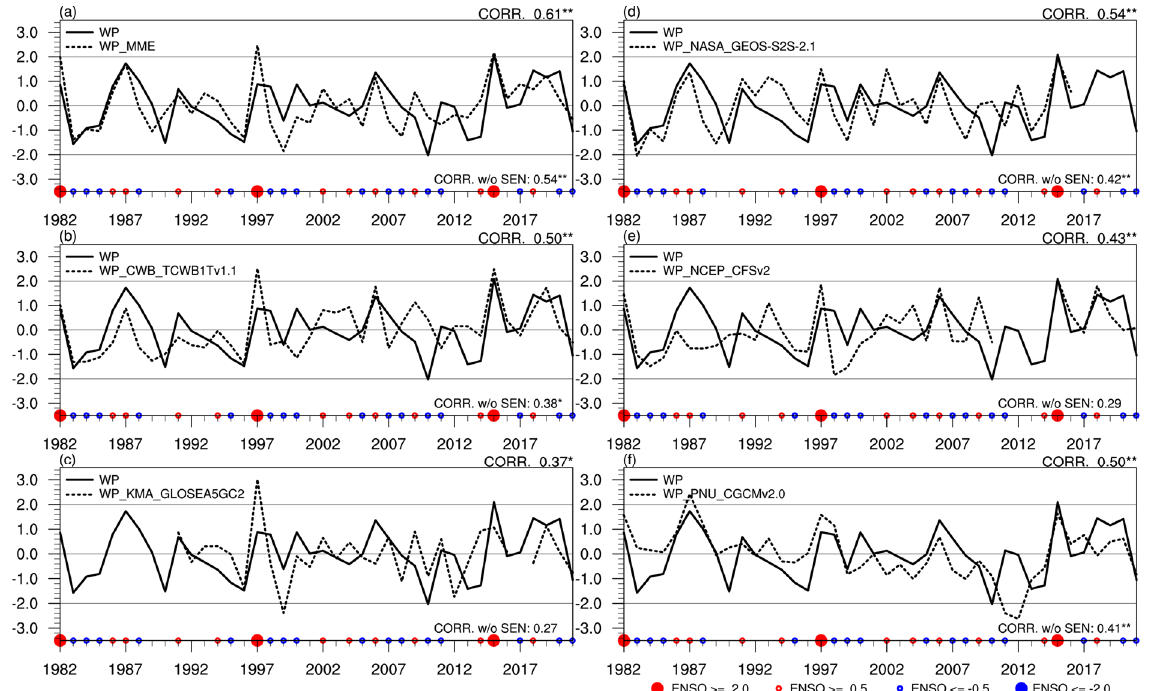
Figure 3. Time series of the WP index observed (solid line) and predicted (dashed line) by the ( a ) MME and ( b – f ) individual models. The status of the ENSO is shown with the circles on the time-axis. The TCC for the entire series (series without SEN years) is shown in the top (bottom) right corner of the panels. Significant at the 99% (95%) level is denoted with a double (single) as- terisk.